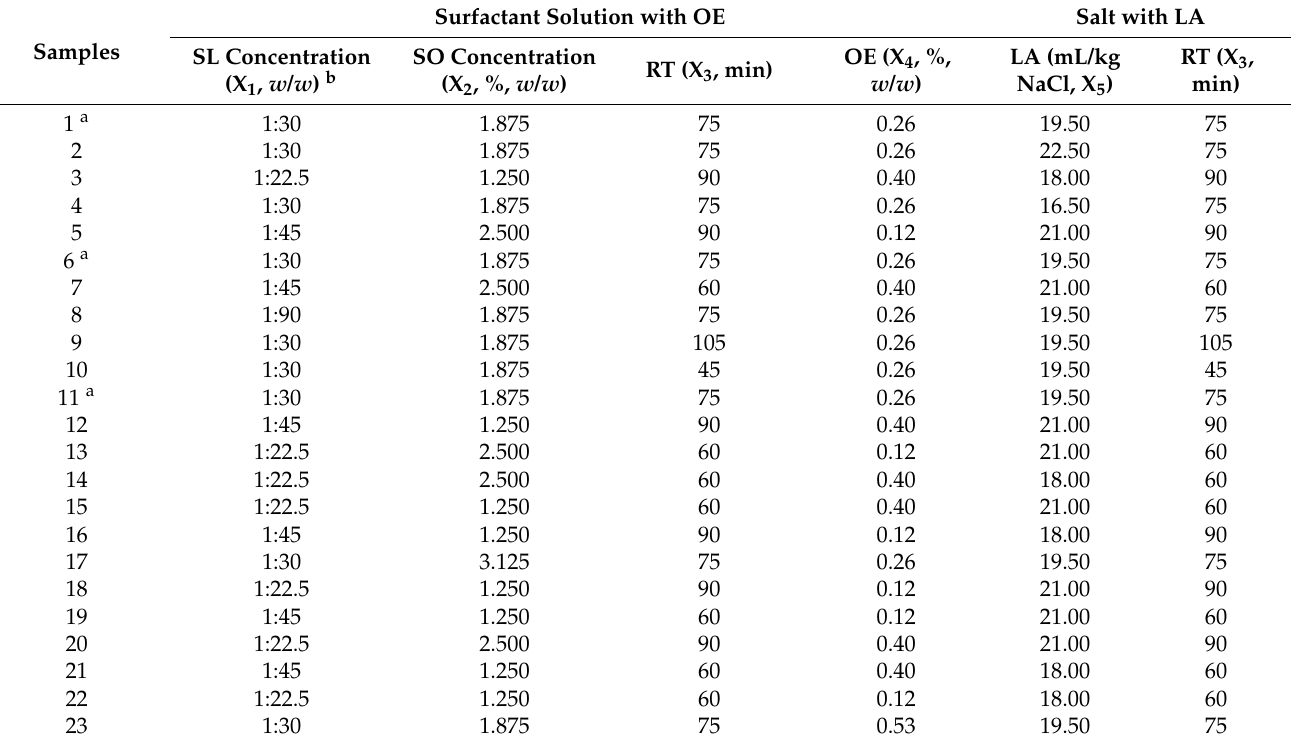
Table 2. Matrix of central composite design for each